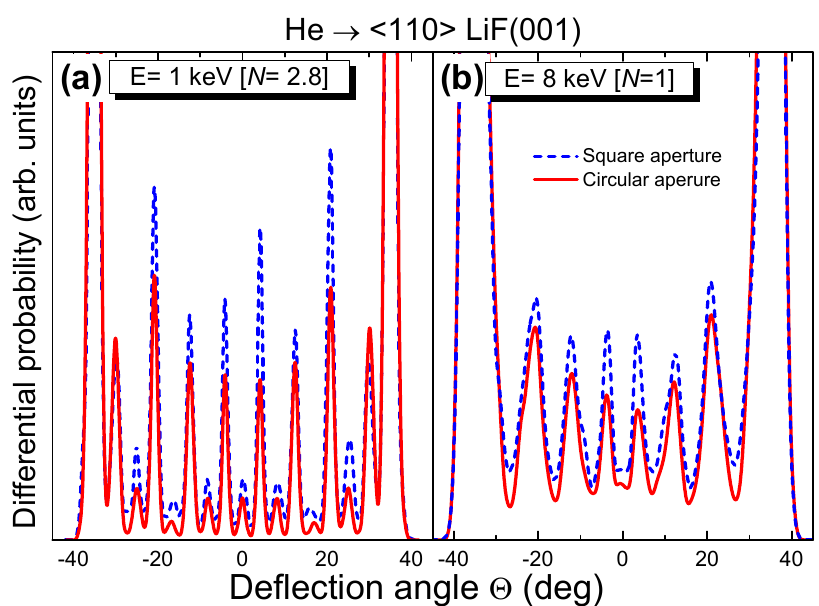
Figure 6. (Color online) Differential probabilities, as a function of the deflection angle Θ , for the cases of Figure 5. Red solid (blue dashed) line, differential probability for the circular (square) collimating